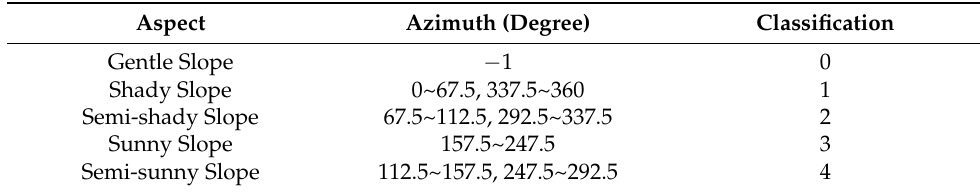
Table 1. Descriptions of aspect classifications.